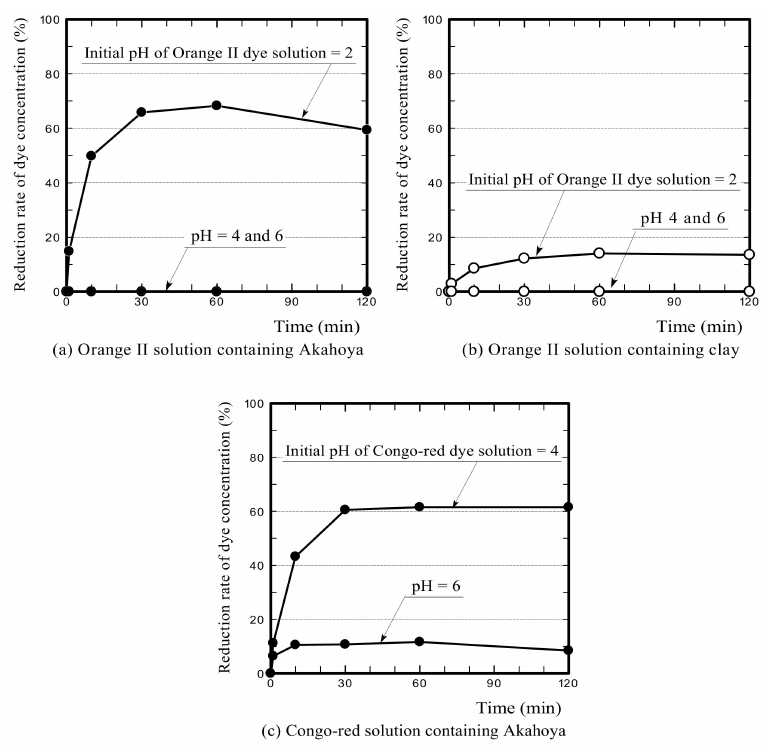
Figure 14. ( a , b ) Orange II concentration reduction rates at an initial pH of 2–6 for the dye solution containing the Akahoya or clay sample, respectively; ( c ) reduction rate of the Congo red concentration at an initial pH of 4 or 6 for the dye solution containing